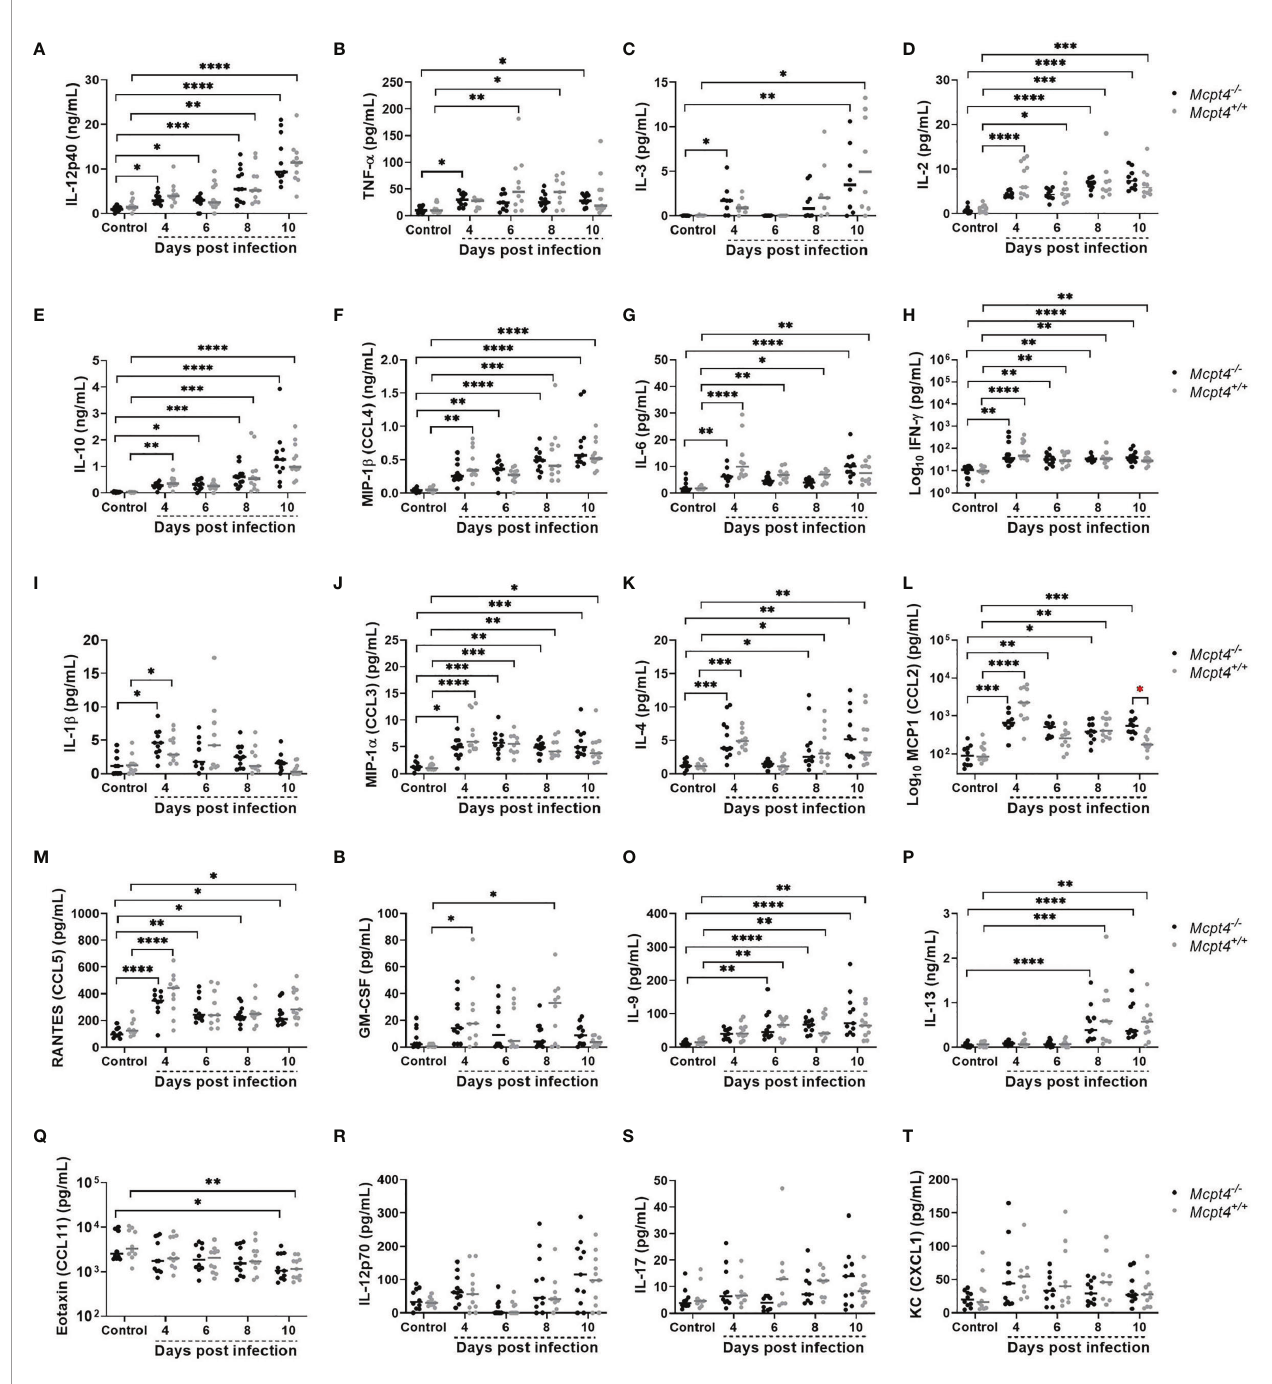
FIGURE 5 | Plasma cytokines and chemokines in P. y. yoelii 17XNL-infected Mcpt4 -/- and Mcpt4 +/+ mice and uninfected controls. (A – T) The x axis represents the time points in days after infection, and the y axis represents the concentrations of IL-12p40 (A) , TNF- a (B) , IL-3 (C) , IL-2 (D) , IL-10 (E) , MIP1 b (CCL4) (F) , IL-6 (G) , IFN- g (H) , IL-1 b (I) , MIP1 a (CCL3) (J) , IL-4 (K) , MCP-1 (CCL2) (L) , RANTES (CCL5) (M) , GM-CSF (N) , IL-9 (O) IL-13 (P) Eotaxin (CCL11) (Q) , IL-12p70 (R) , IL-17 (S) and KC (CXCL1) (T) . Each dot represents a single mouse. Plasma cytokines were determined for the three biological replicates (n=11 mice per group per time point). Data were analyzed with the Kruskal-Wallis test followed by Dunn ’ s multiple comparison for each time point versus control or between Mcpt4 -/- and Mcpt4 +/+ mice at speci fi c time points. P values ≤ 0.05 were considered signi fi cant. *P ≤ 0.05, **P ≤ 0.01; ***P ≤ 0.001, **** P ≤